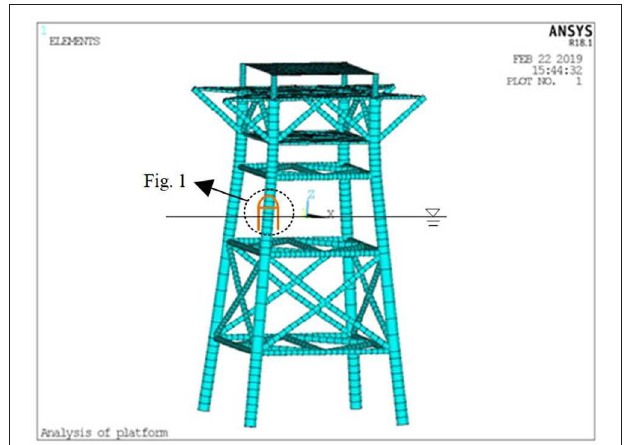
FIGURE 2 | Finite element